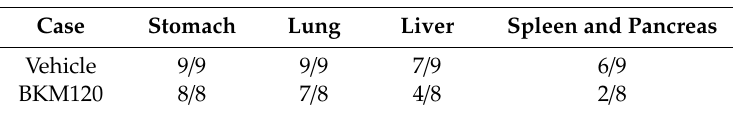
Table 3. Number of tumor-bearing mice per total NSG mice implanted with MKN45 and treated with BKM120 and vehicle (DMSO-treated mice).